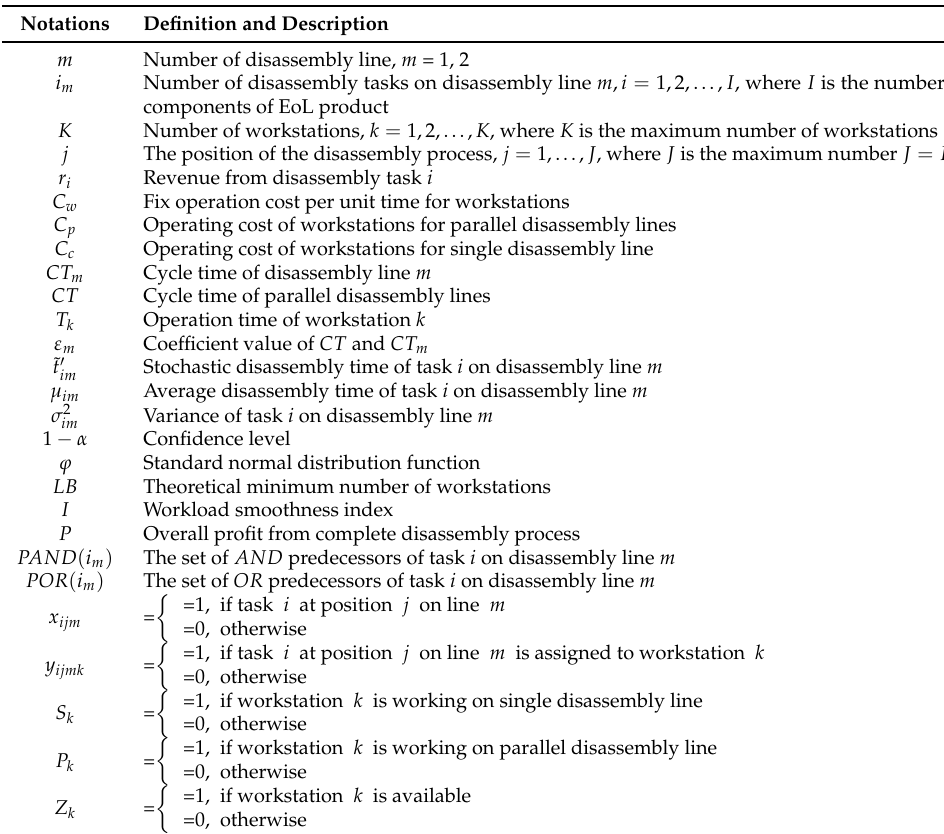
Table 1. Definition and description of